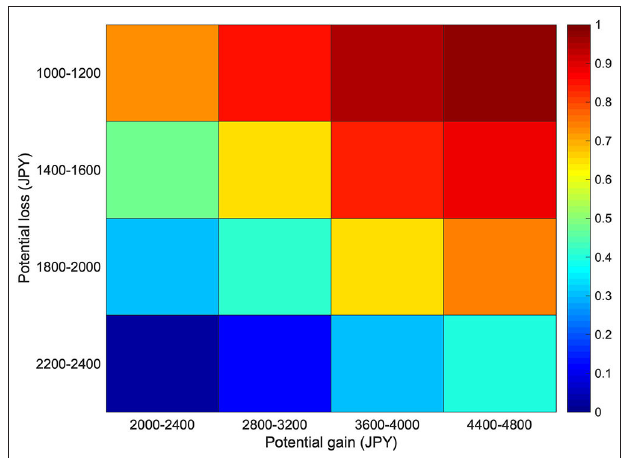
FIGURE 2 | Probability of gamble acceptance. Color-coded heatmaps depicting the probability of gamble acceptance at each level of gain/loss within that cell averaged across all subjects ( n = 26). One cell consists of four potential gain/loss combinations. Red indicates high willingness to accept the gamble, and blue indicates low willingness to accept the